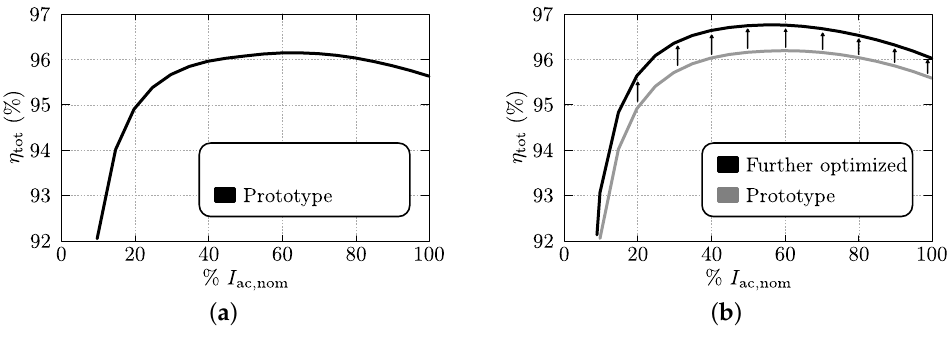
Figure 21. Calculated efficiency of the 1-S DAB ac-dc converter implemented according to ( a ) converter design A (prototype converter) and ( b ) converter design B (further